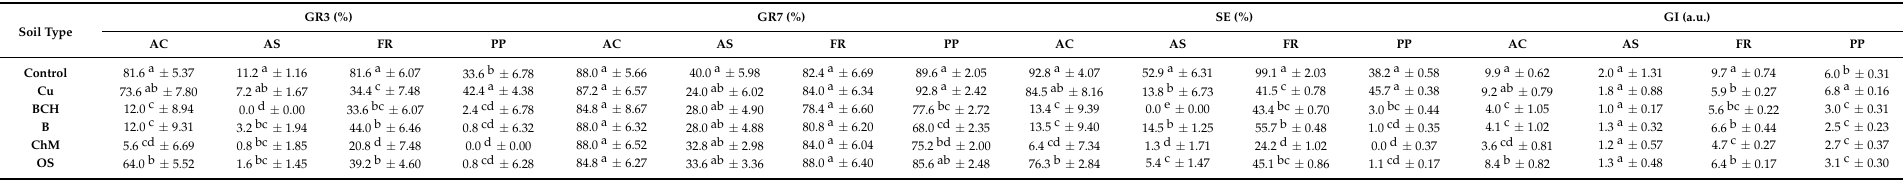
Table 1. Values of selected germination indexes of grass seeds recorded on various modifications of soil contaminated with copper; mean values ( n = 5; ± SD) marked with different letters (within each species, in columns) differ significantly according to Duncan’s test with p ≤ 0.05. GR3(%) GR7(%) SE(%) SoilType